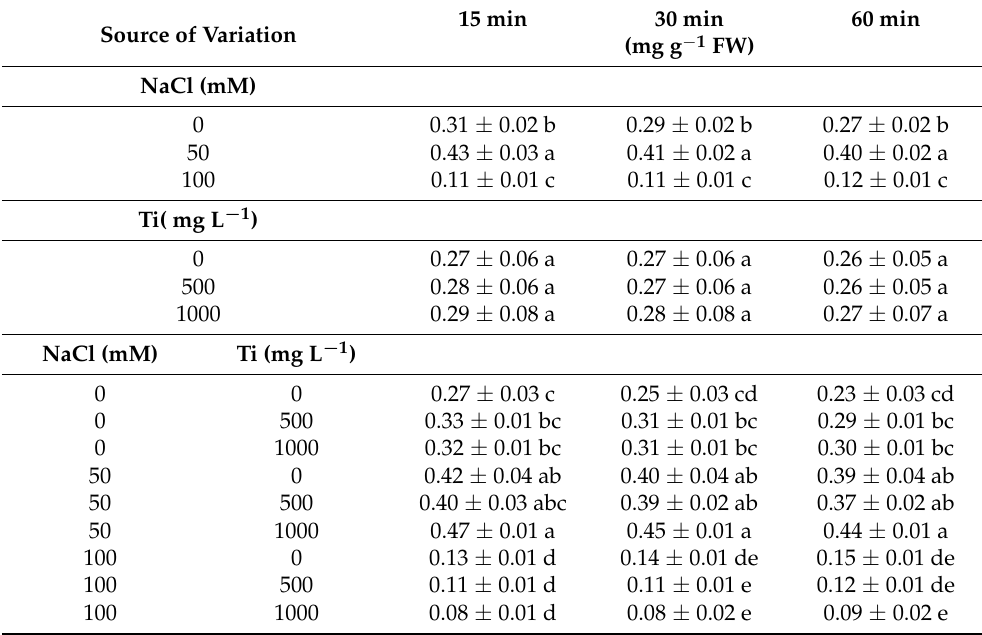
FW= fresh weight. Means ± SD with different letters in each column indicate statistically significant differences between treatments (Tukey, p ≤ 0.05). Table 6. Main and interaction effects of NaCl and TiO 2 on antioxidant activity at 15, 30, and 60 min in roots of tomato ( Solanum lycopersicum L.) seedlings cv. Rio